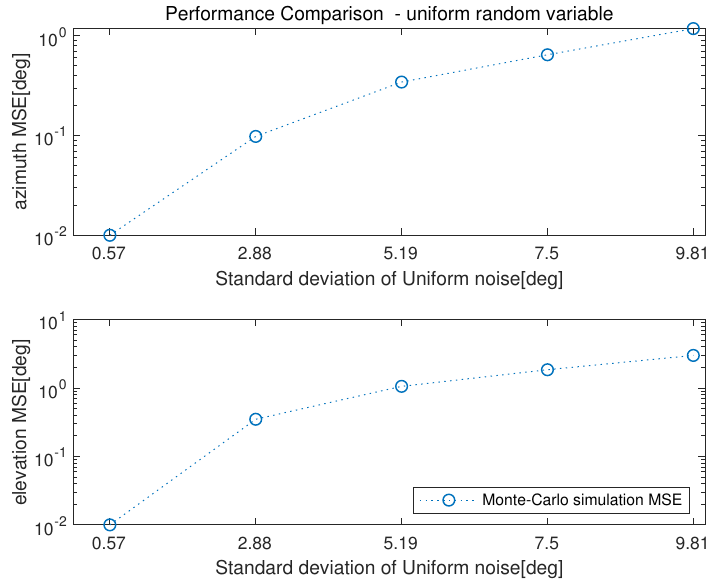
Figure 12. Performance for uniformly − distributed phase measurement error with θ ( 0 ) = 120 ◦ and ψ ( 0 ) = 45 ◦ . This figure shows the MSEs of azimuth and elevation with respect to phase error at a signal with low incident elevation by monte-carlo simulation(rectangular planar